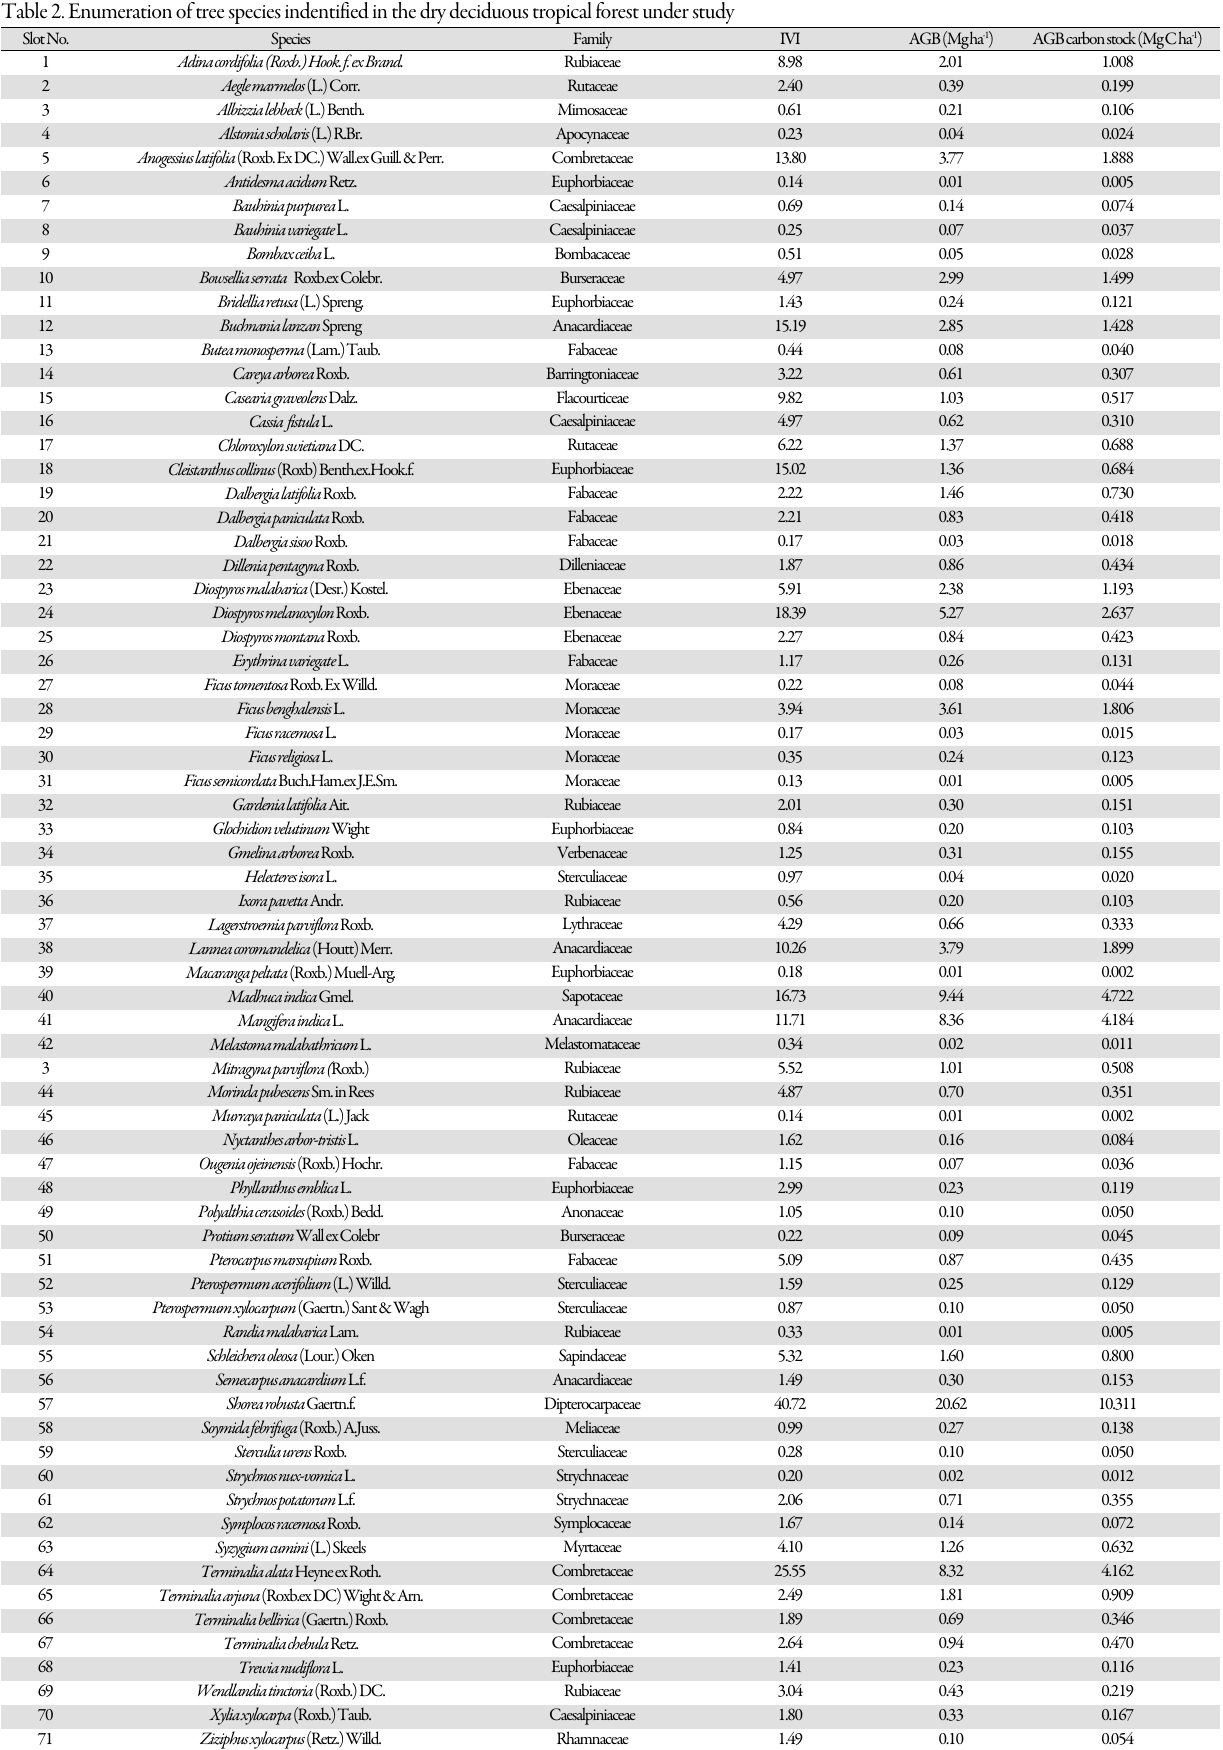
Table 2. Enumeration of tree species indentified in the dry deciduous tropical forest under